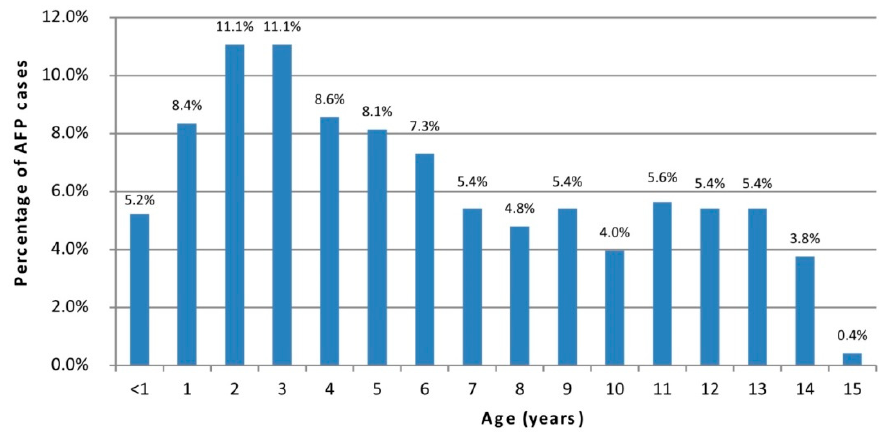
Figure 1. Percentage of AFP cases by age.